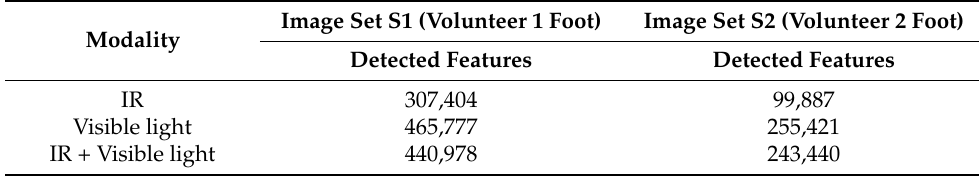
Figure 19. Detected feature points (red dots) and visualization of their correspondence (the green lines represent the link between homologous points). This figure represents 202 matches between images 6 and 7 from set S1, in which most of the key points were dismissed, proving that the quality of the model depends on the accuracy of the matching points’ process. Table 7. Detected and matched features in the two consecutive multimodal